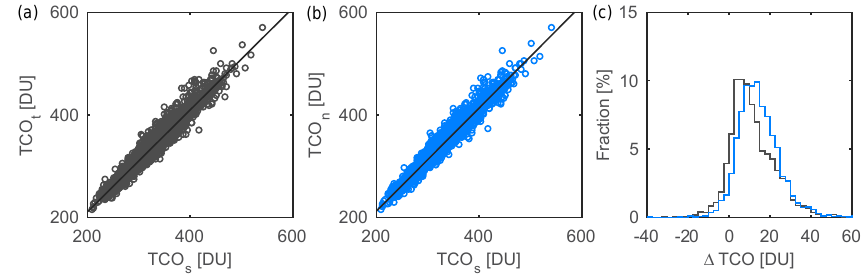
Figure 4. (a) Traditional BRDV with traditional DS–ZS choice vs. Ozone Monitoring Instrument (OMI) mean overpass. (b) BRDV from described methodology vs. OMI mean overpass. (c) Histogram of daily differences between traditional (grey) and new (blue) daily TCO calculations vs. satellite overpass